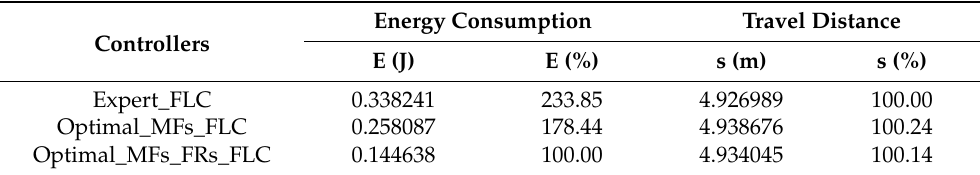
Figure 19. The simulation results in the case of using the straightforward path. ( a ) The trajectory of the robot; ( b ) The robot’s travel distance over time; ( c ) The robot’s linear velocity over time; ( d ) The robot’s angular velocity over time; ( e ) The robot’s kinetic energy loss over time; and ( f ) The zoom of the robot’s kinetic energy loss over time. Table 18. The kinetic energy loss and the travel distance of the robot when the robot tracks the straightforward path by the different